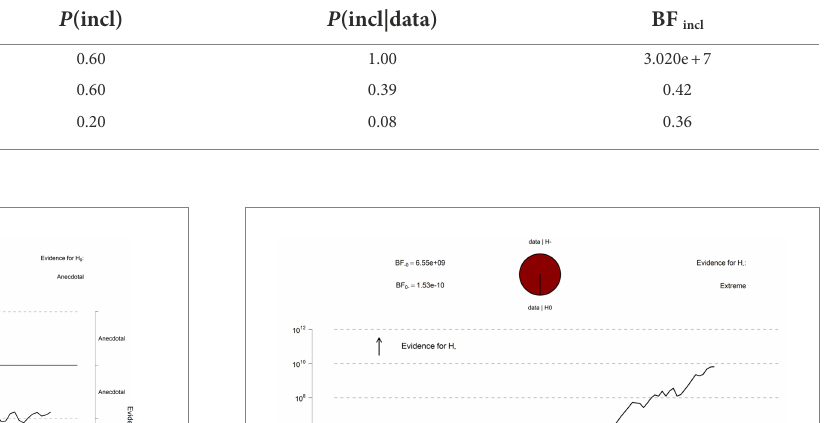
TABLE 5 Analysis of effects for the Bayesian repeated measures ANOVA on